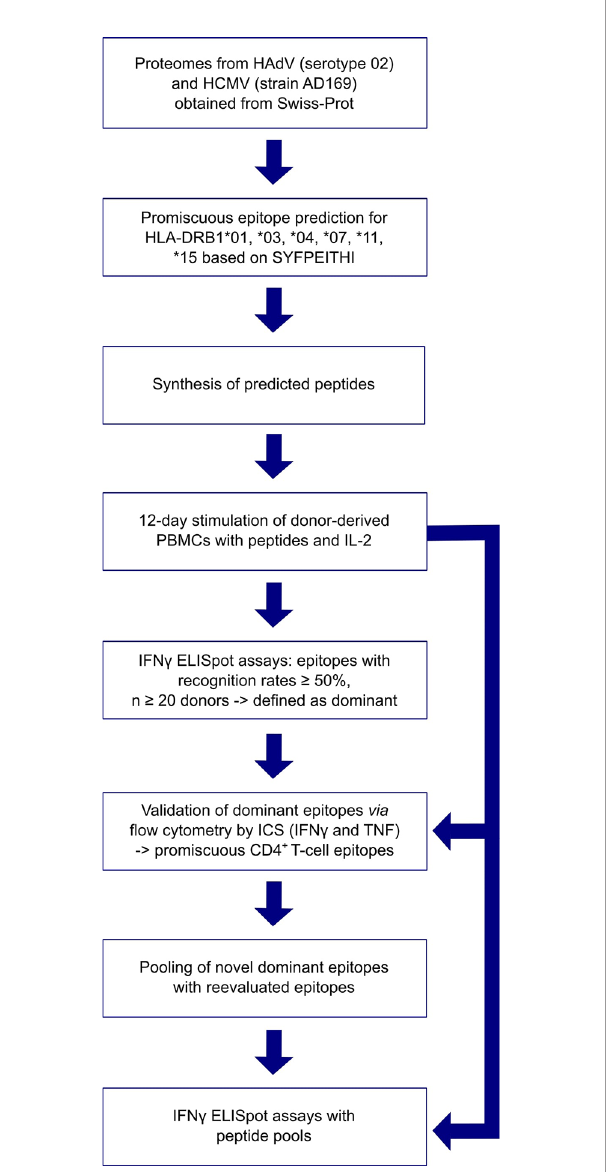
FIGURE 1 | Overview of applied